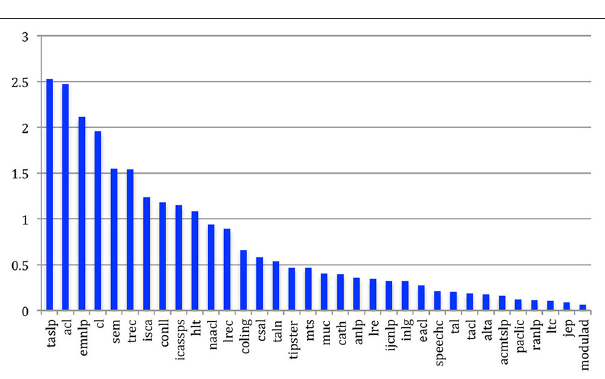
FIGURE 51 | Mean degree of citing and cited papers within the same source for the 34 sources.